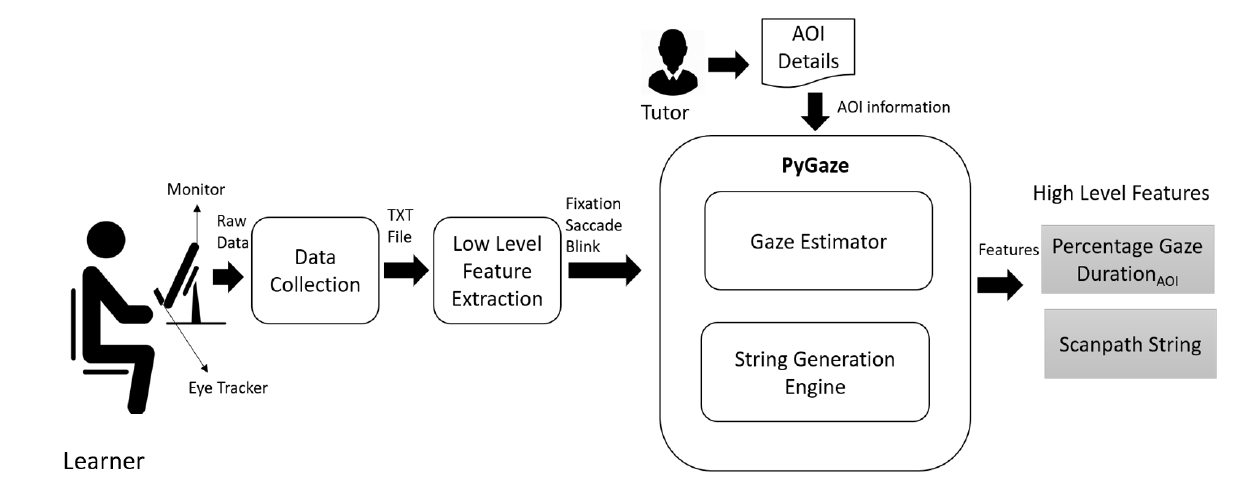
Figure 4. High Level Feature